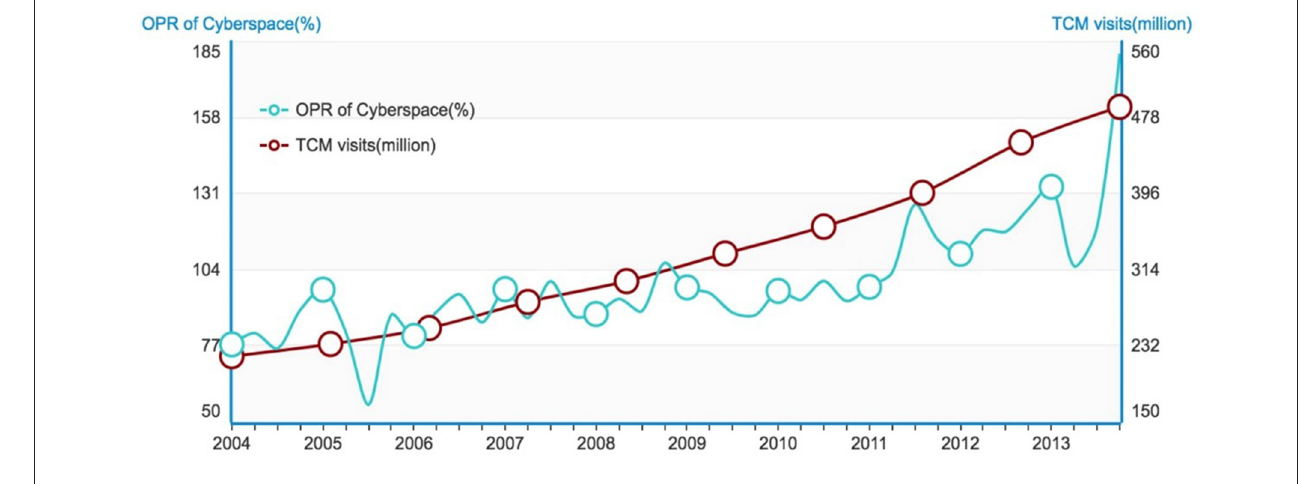
FIGURE 1 | OPR of Cyberspace vs. TCM visits.